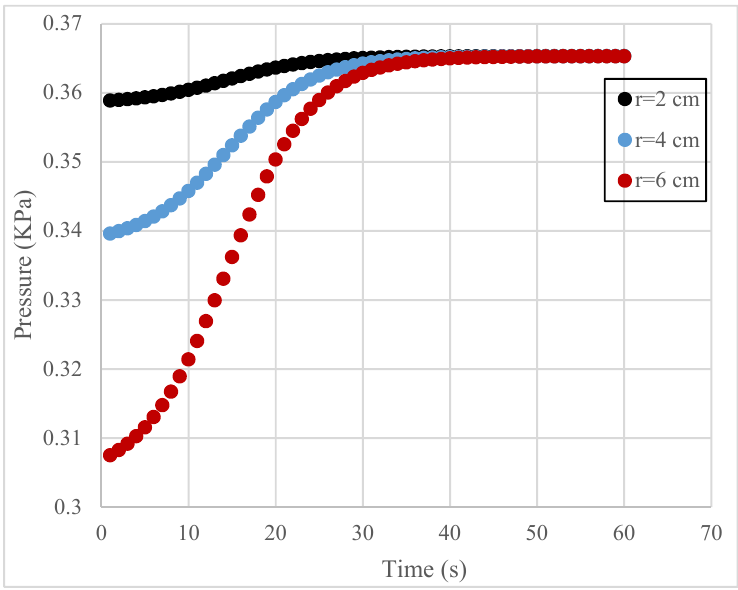
Figure 9. Pressure versus time curves at different distances.